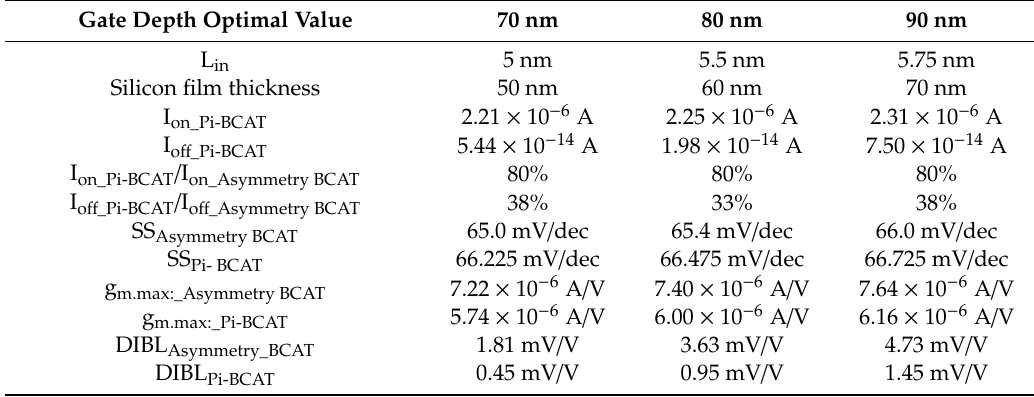
Table 1. Electrical characteristics: Pi-BCAT with optimal parameters and asymmetry